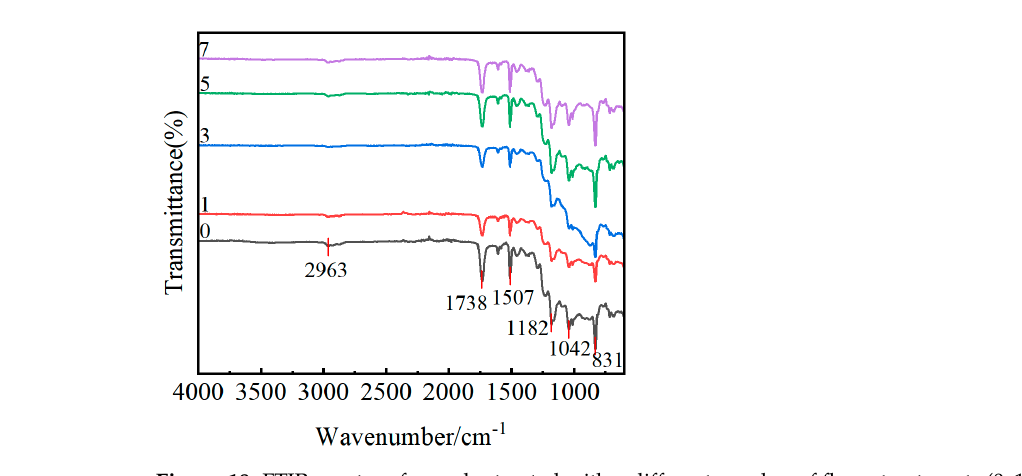
Figure 17. FTIR spectrum of release agent INT − 1890M.